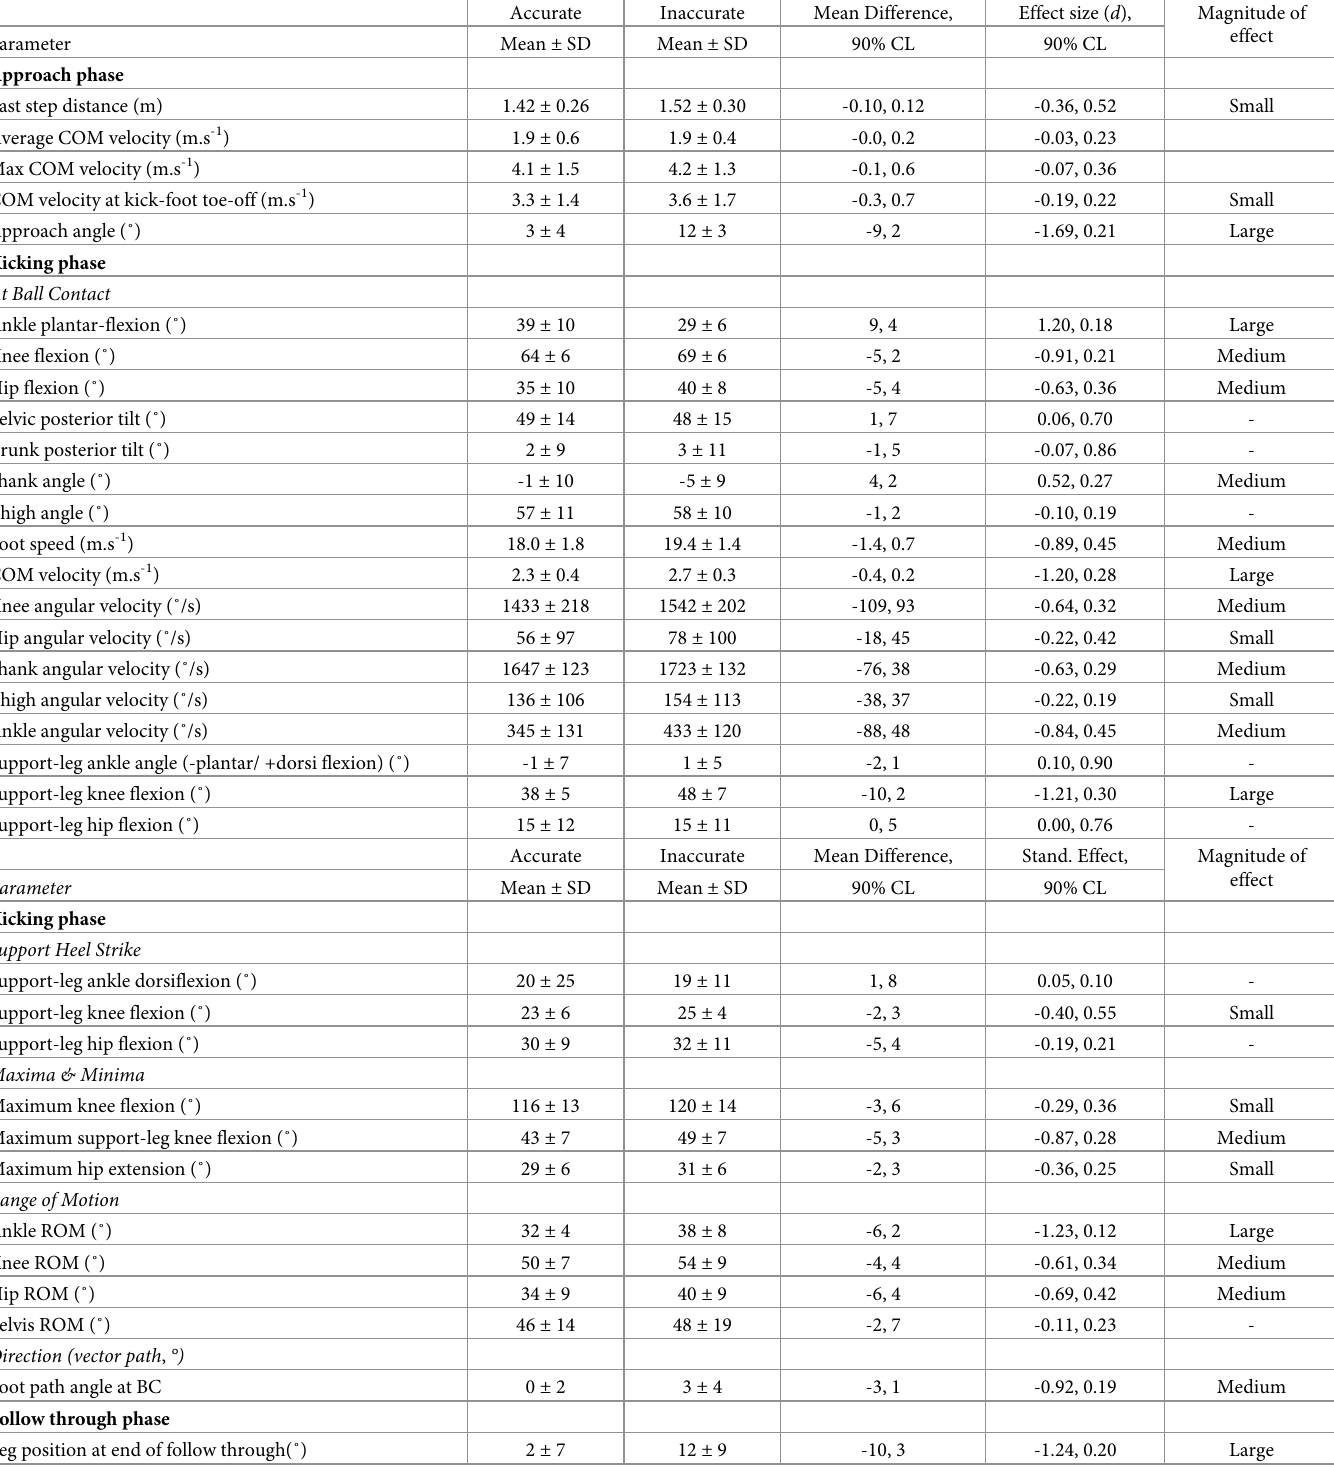
Table 2. Kinematic means ± standard deviations (SD) for accurate (hit) and inaccurate (miss) goal-kicks, mean differences between goal-kicks (Hit-Miss), with 90% confidence limits (CL), effect size ( d ), with 90% CL, and the magnitude of the effect for each parameter. All parameters relate to the kick-leg unless